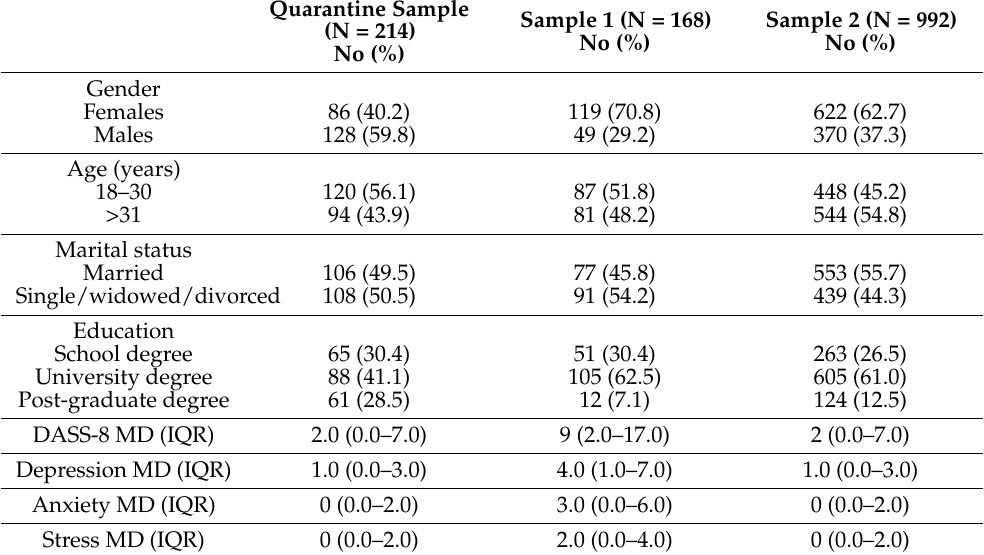
Table 1. Sociodemographic characteristics of included